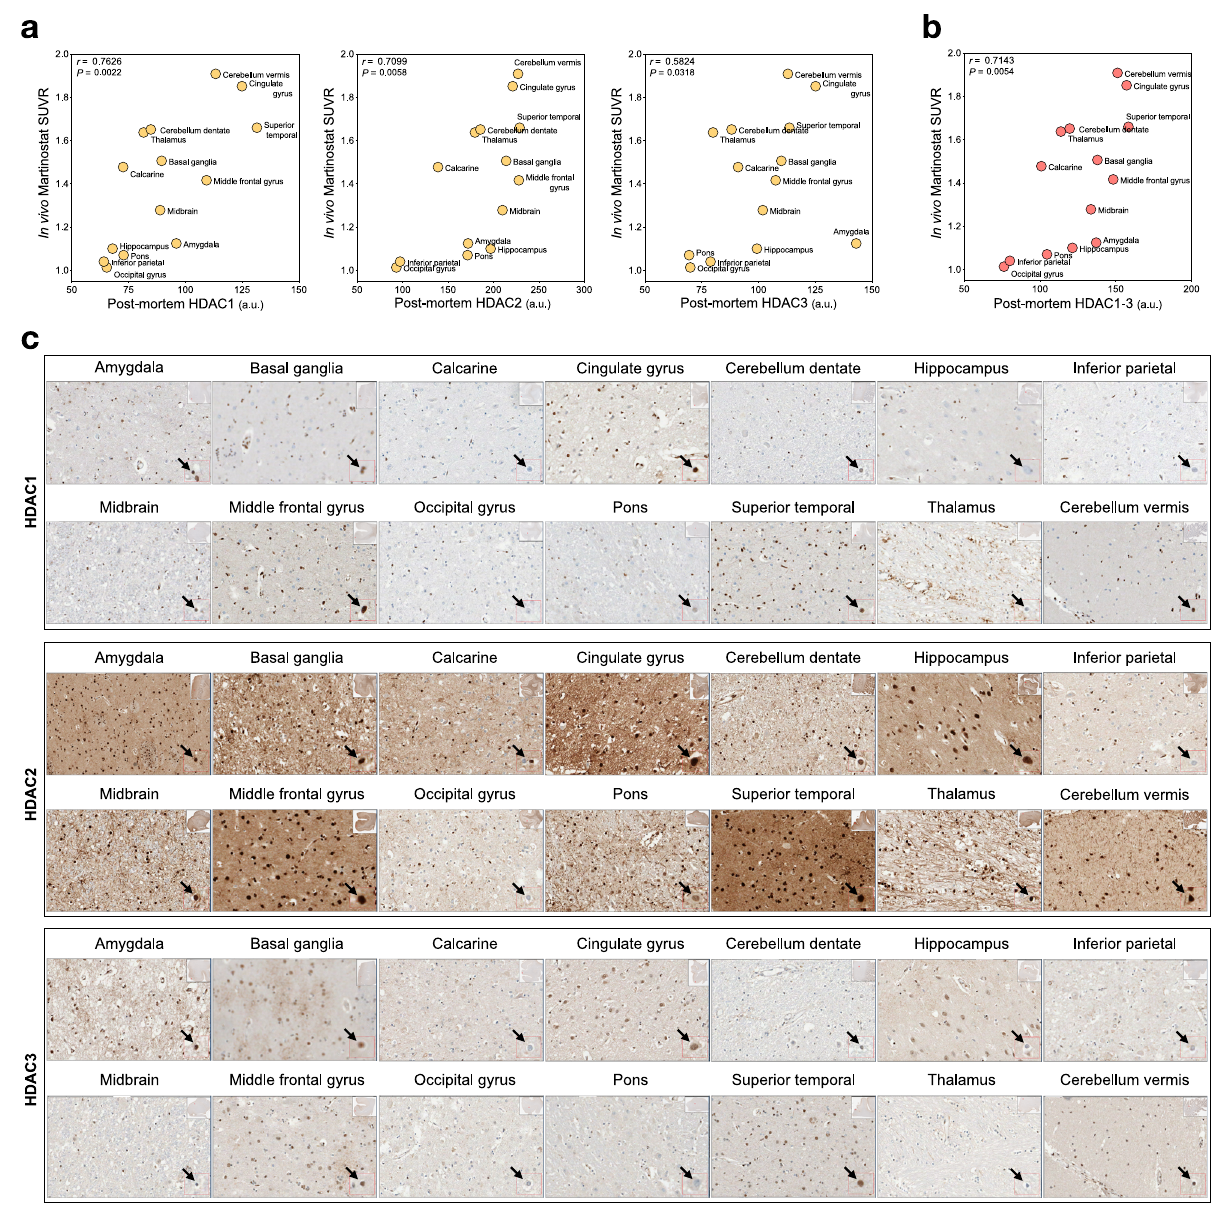
Fig. 1 In vivo [ 11 C]Martinostat SUVR correlates with postmortem HDAC1 – 3 levels. Scatter plots show two-sided Spearman ’ s correlation between in vivo [ 11 C]Martinostat SUVR and postmortem nuclear a HDAC1 – 3 and b their averaged values in corresponding brain regions in an AD participant who underwent a [ 11 C]Martinostat scan before death. c The panels show immunohistochemical stains for HDAC1, HDAC2, and HDAC3 across all the studied brain regions in the patient with AD. The arrows show magni fi ed representative neuron nucleus from where HDACs levels were measured. a.u. arbitrary unit. Source data are provided as a Source Data fi